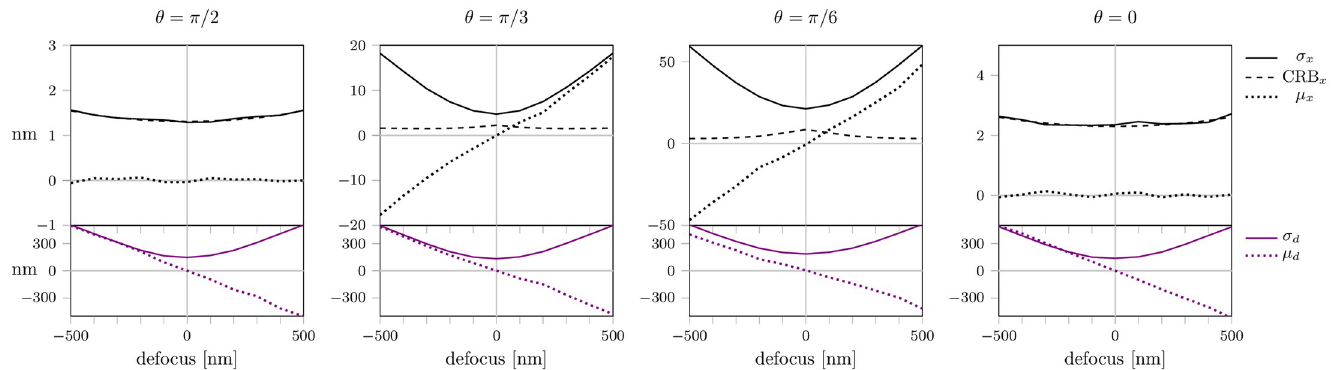
Fig 2. Localization errors without astigmatism. We fitted the position and defocus ( x , y , d ), while the dipole orientation ( θ , ϕ ) was assumed to be known exactly. Shown are localization precision σ x , σ d (solid lines) and bias μ x , μ d (dotted lines) for the x -position (black) and defocus values d (violet), respectively, that arise in astigmatism-free imaging for dipole orientations with inclinations angle θ = π /2, π /3, π /6, 0 and azimuthal angle ϕ = π /4. For symmetry reasons, localization precision and bias for the x - and y -position are identical in the astigmatism-free case. The CRB for localization along the x -direction is indicated by the dashed line. The number of photons was set to N = 5 � 10 5 and the background noise to b = 300. Each data point represents 1000 simulations.